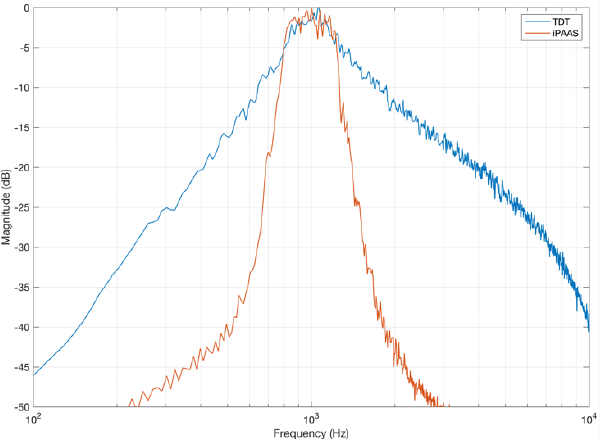
Figure 3. Averaged spectra of the laboratory-based system (TDT) and iPAAS band-limited noise stimuli used for gap detection.